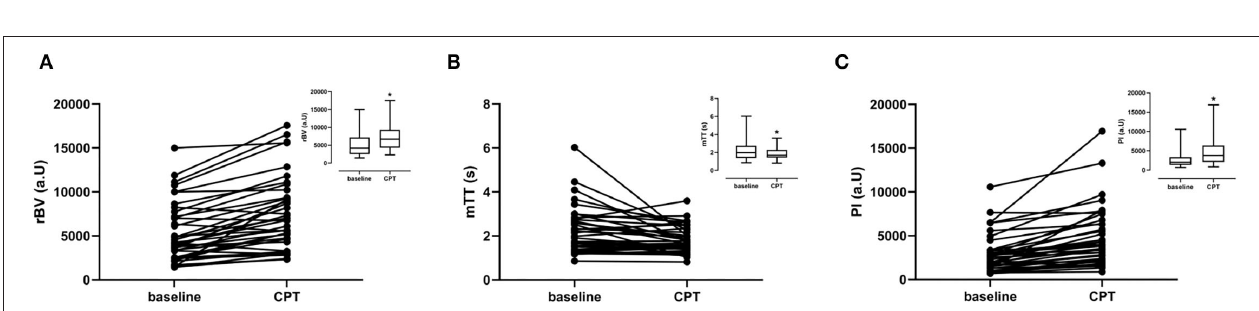
FIGURE 4 | CEUS parameters per subject for baseline and CPT. Graph inserts are the mean values ± SD. (A) Relative blood volume (rBV). (B) Mean transit time (mTT). (C) Perfusion index (PI).